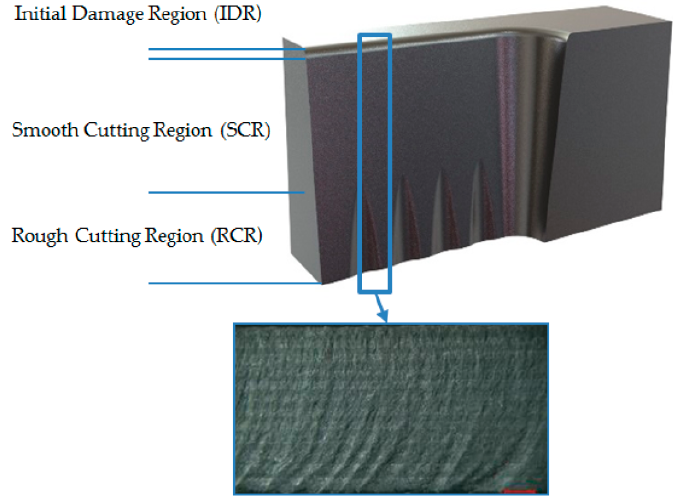
Figure 4. Surface geometry variation along the cutting depth [53].